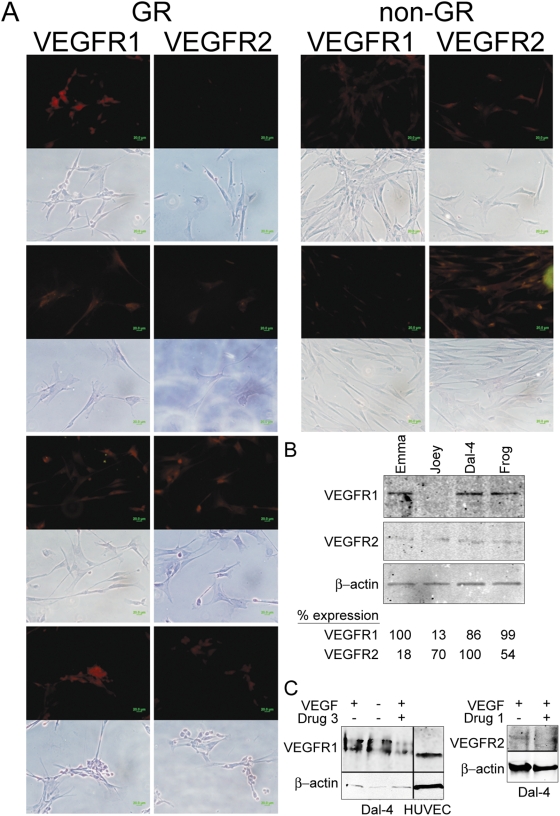
Expression of VEGF Receptors in Hemangiosarcoma Cells of Golden Retrievers and Non-Golden Retrievers.A. Hemangiosarcoma cells from 4 Golden Retrievers (in order from top to bottom, Frog, Veronica, Tucker, Emma) and from 2 non-Golden Retrievers (Dal-4 and Joey) were cultured in chamber slides and stained with antibodies against VEGFR1 and VEGFR2 as described in the methods. Staining was visualized using epifluorescence. Bar = 20 µm. B. Emma, Frog, Joey, and Dal-4 cells obtained during the log growth phase were used to quantify expression of VEGFR1, VEGFR2 and ß-actin by immunoblotting. Conditions were optimized for linearity. Densitometric band quantification was done using Image J 1.37. Data are normalized to ß-actin using the sample with the highest expression for each receptor as the calibrator. C. Dal-4 cells were cultured in complete media supplemented with VEGF (+), in the absence of serum and growth supplements (−), with or without Drug 3 (100 nM) or Drug 1 (1 µM) as indicated. The activation status of VEGFR1 and VEGFR2 was examined using modification-state (phosphospecific) antibodies directed against pVEGFR1-Tyr915 and pVEGFR2-Tyr875. ß-actin was used as a loading control, and HUVEC lysates were used as a specificity control for VEGFR1.